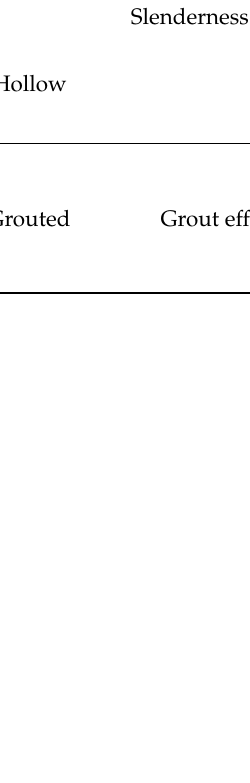
Table 4. FE results of the hollow and grouted prism with different